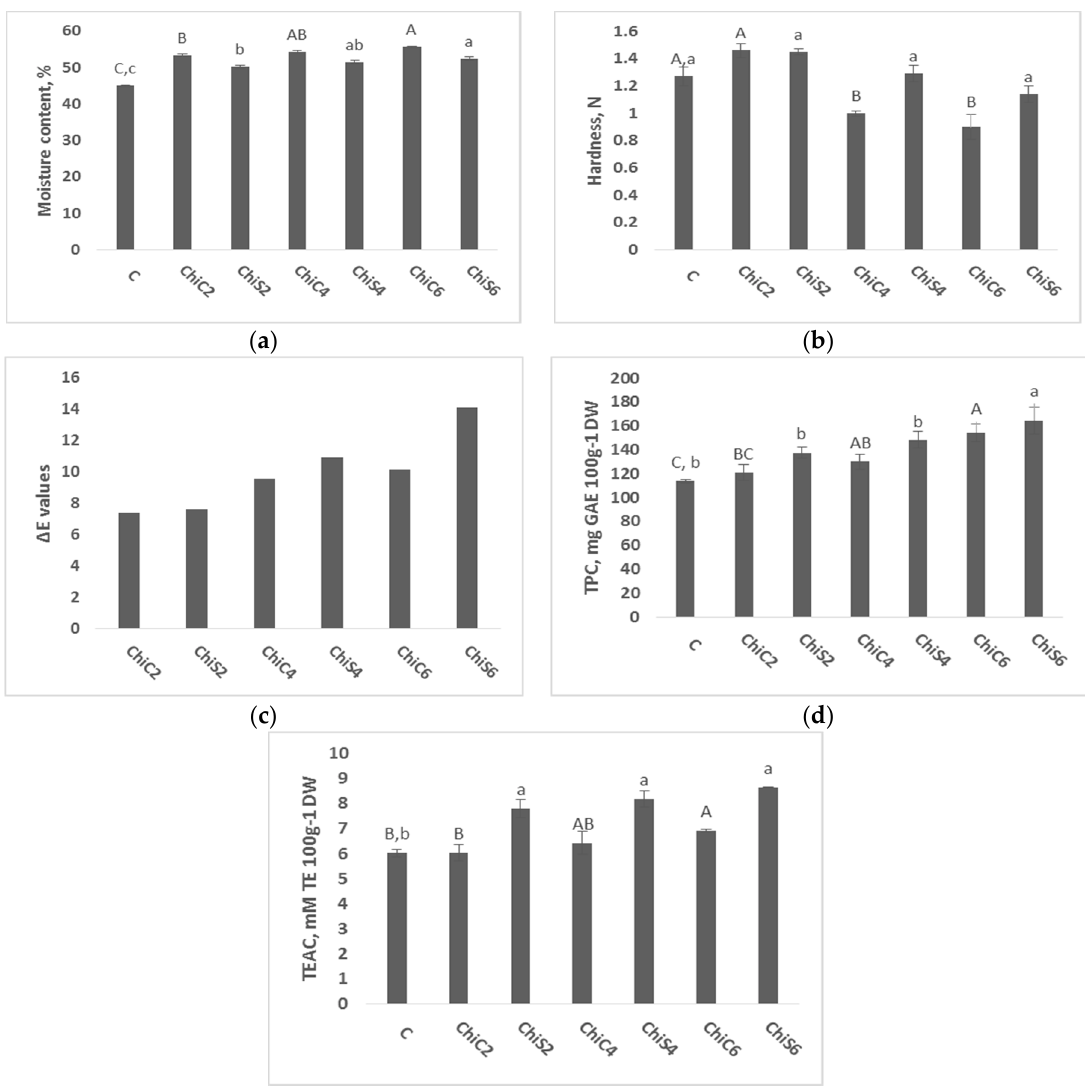
Figure 1. ( a ) Moisture content (%); ( b ) hardness (N); ( c ) Total color difference ( Δ E ); ( d ) Total phenolic content (TPC, expressed as mg GAE 100 g − 1 DW); ( e ) Trolox equivalent antioxidant capacity (TEAC expressed as mM TE 100 g − 1 DW) of whole wheat bread samples fortified with chia seed powder and cakes. Column marked with the same subscript letters in each bar chart are not significantly different ( p > 0.05).